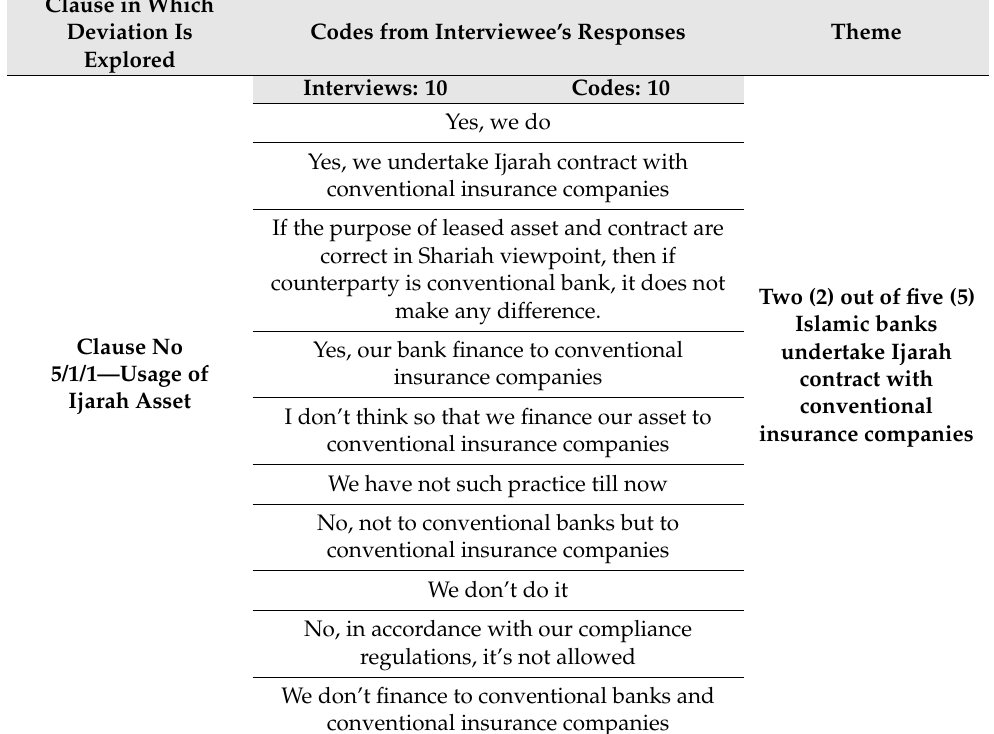
Table A4. Clause 5/1/1—usage of the Ijarah asset. Clause in Which Deviation